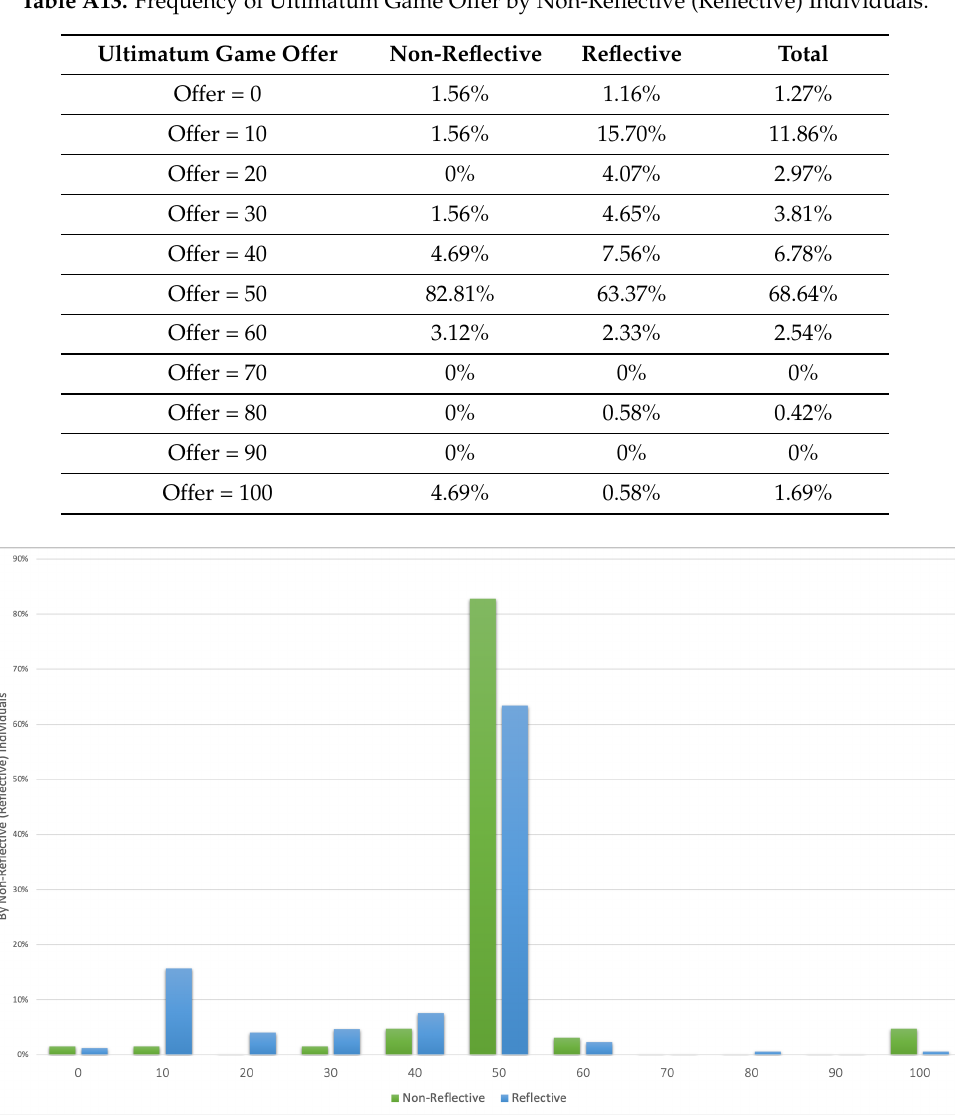
Table A13. Frequency of Ultimatum Game Offer by Non-Reflective (Reflective) Individuals.